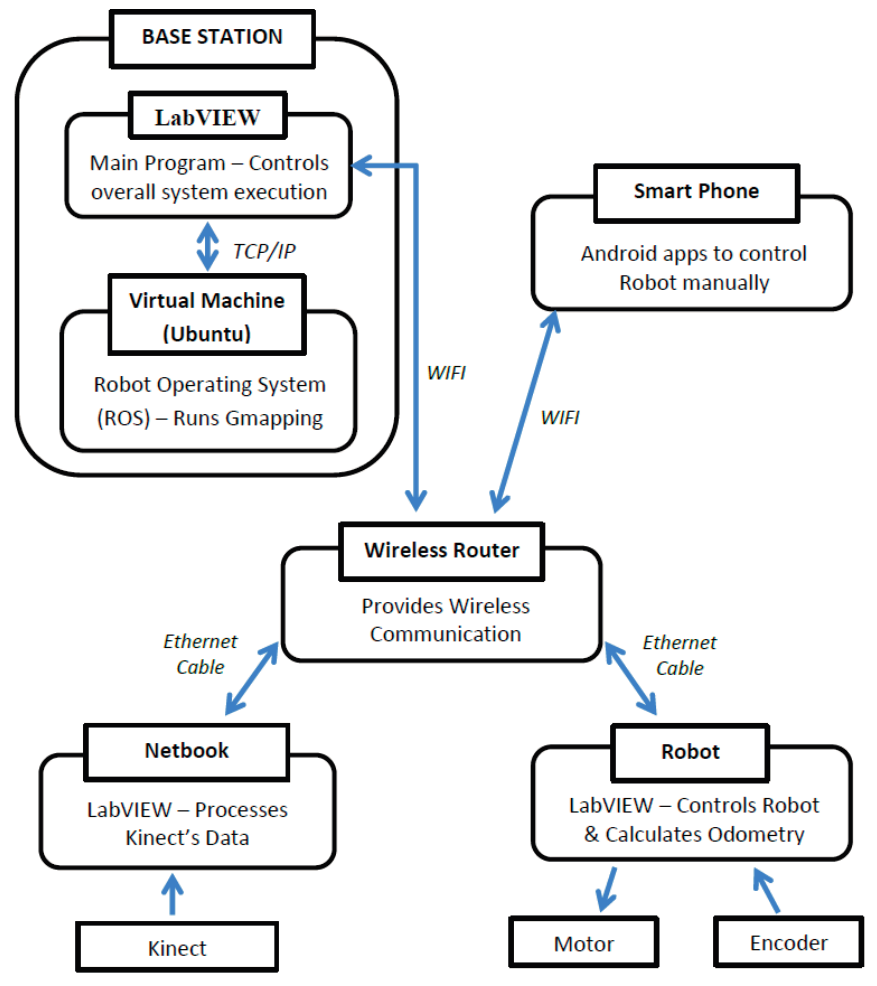
Figure 2. Architecture of the integrated